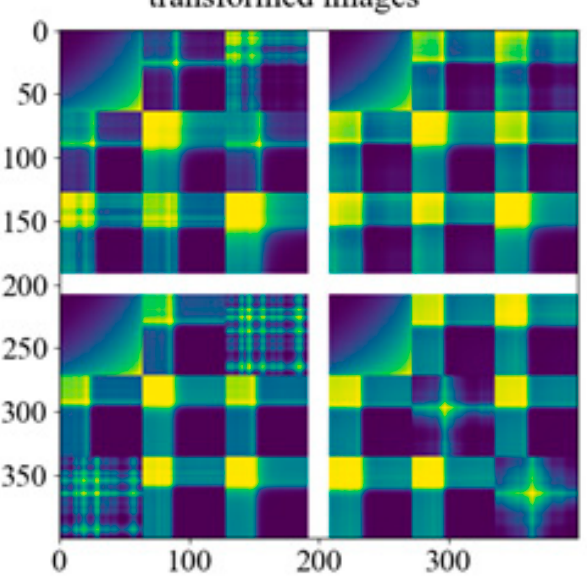
Figure 7. The two-dimensional combination sensor images of the four gases. The x and y axis represent the number of pixels converted from the gas sensing response data to the gas sensing image.